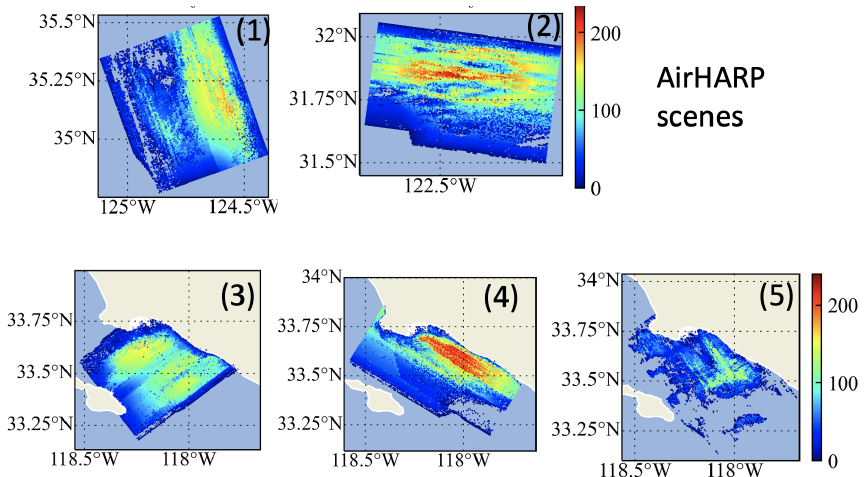
Figure 13. The number of total viewing angles ( N ) considering both reflectance and DoLP for the five AirHARP ocean scenes from ACE- POL.